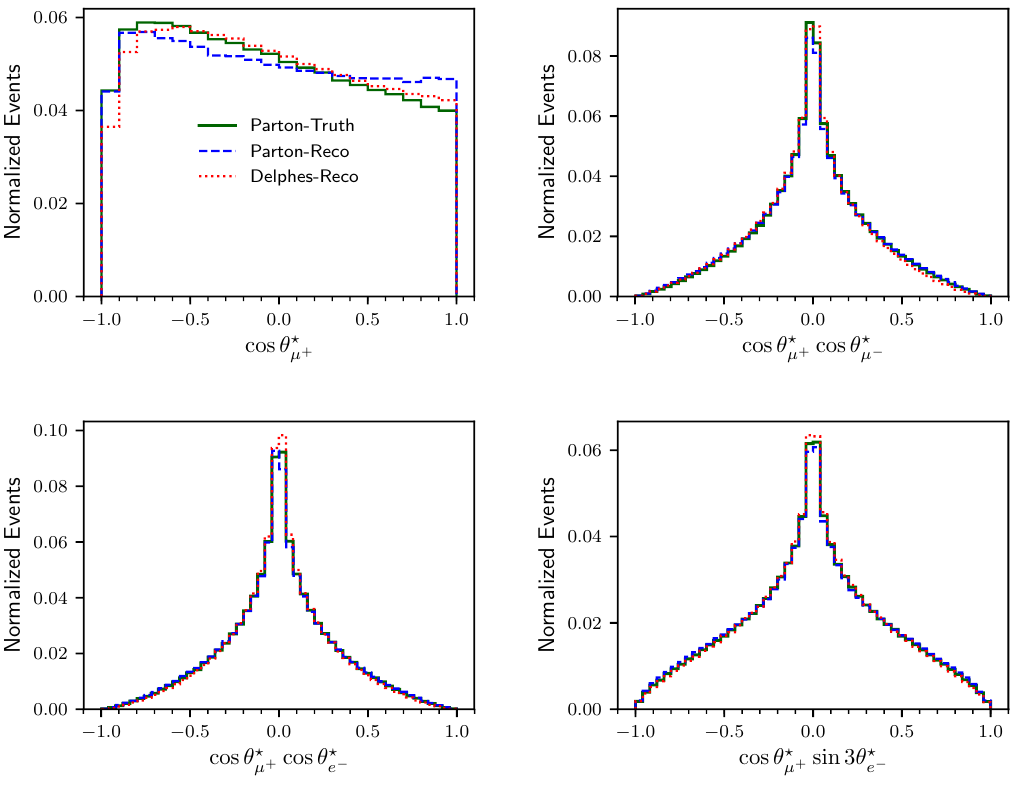
Figure 2 . Normalized distributions of angular functions for polarizations and two-body spin corre- lations ( p t in left-top , pp t ¯ t in right-top , pp tZ in left-bottom , and pT tZ in right-bottom panel) in the z zz zz z ( zz ) rest frame of t , ¯ t and Z for three scenarios namely Parton-Truth , Parton-Reco and Delphes-Reco .